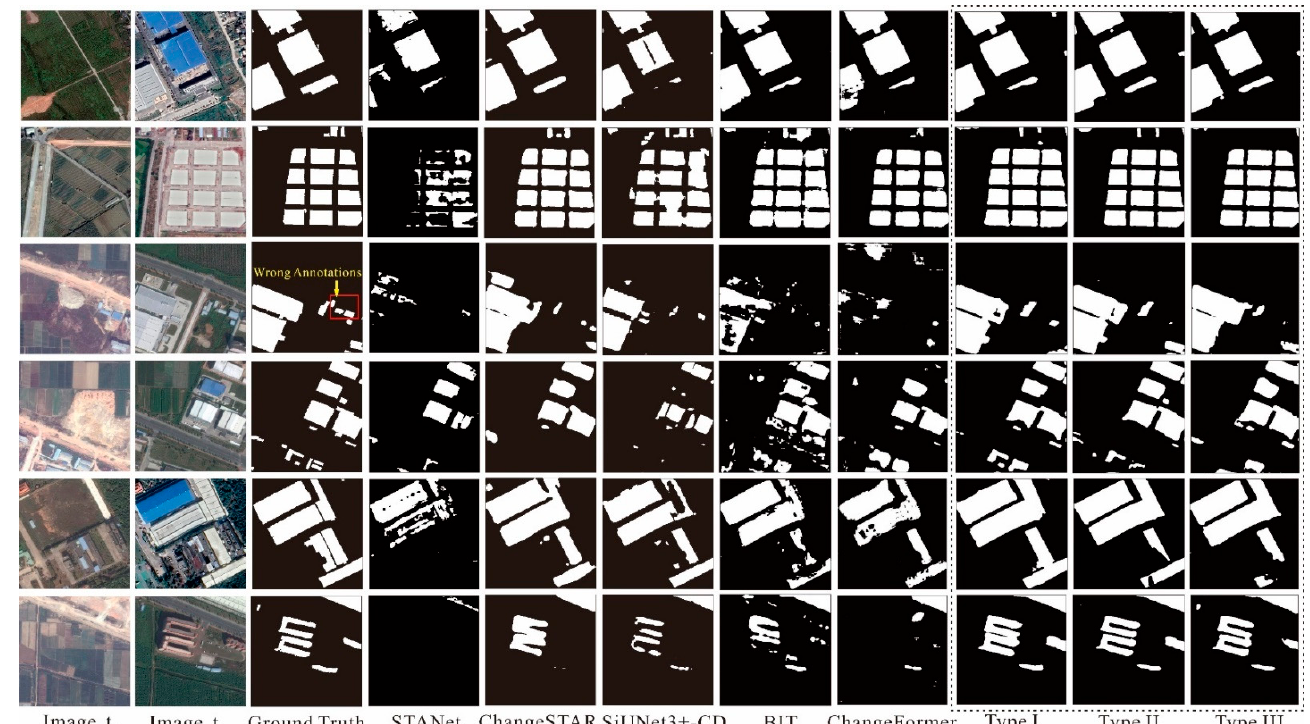
Figure 6. Visualized results of STDecoder ‐ CD series models and the compared methods on the PIESAT ‐ CD dataset. Red rectangles represent missing annotations in the labels. Red ellipses high ‐ light typical false alarms. Note: due to limited space, we could not show the prediction results of all of the algorithms listed in Table 1.